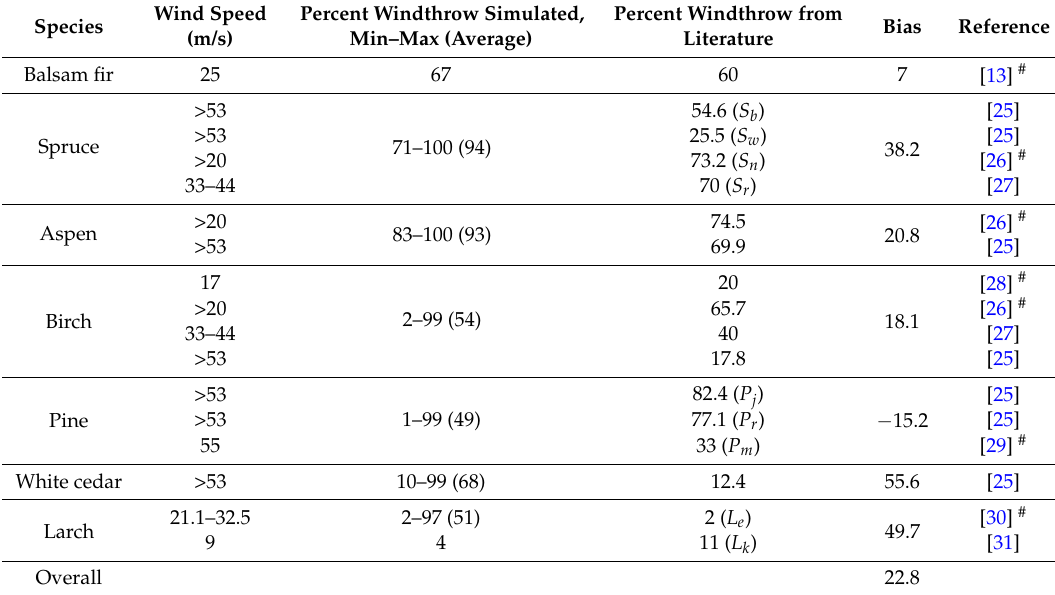
Table 5. Windthrow damage levels reported in literature by